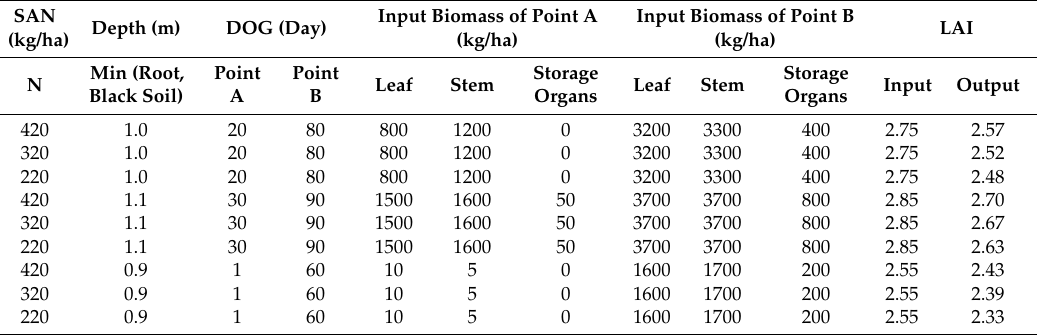
Table 1. The N table of the LUT